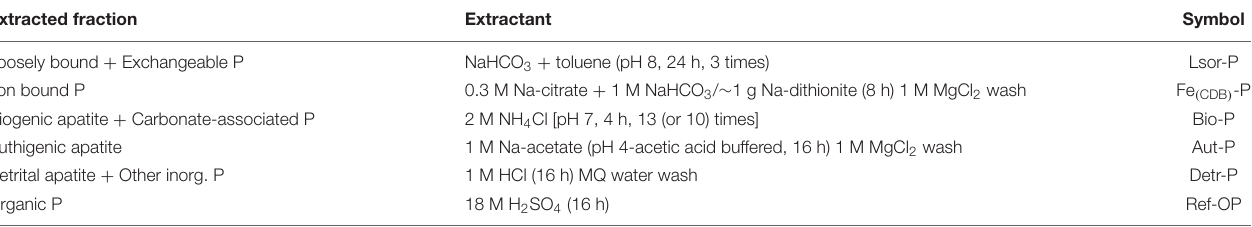
TABLE 1 | Sequential extraction scheme for P fractions in the sediments. Extracted fraction